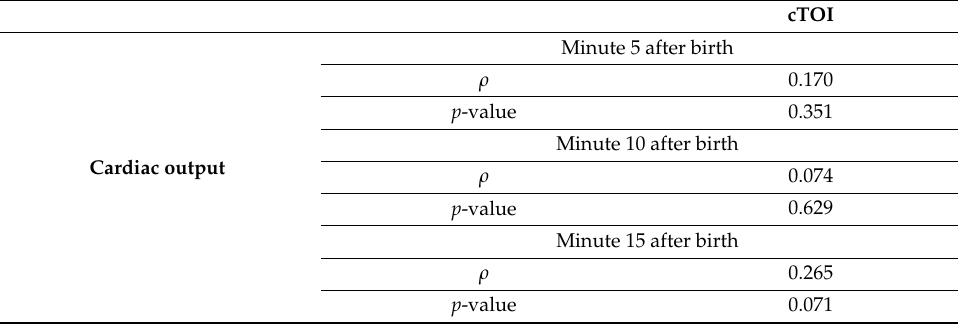
Table 3. Correlation analyses between CO and